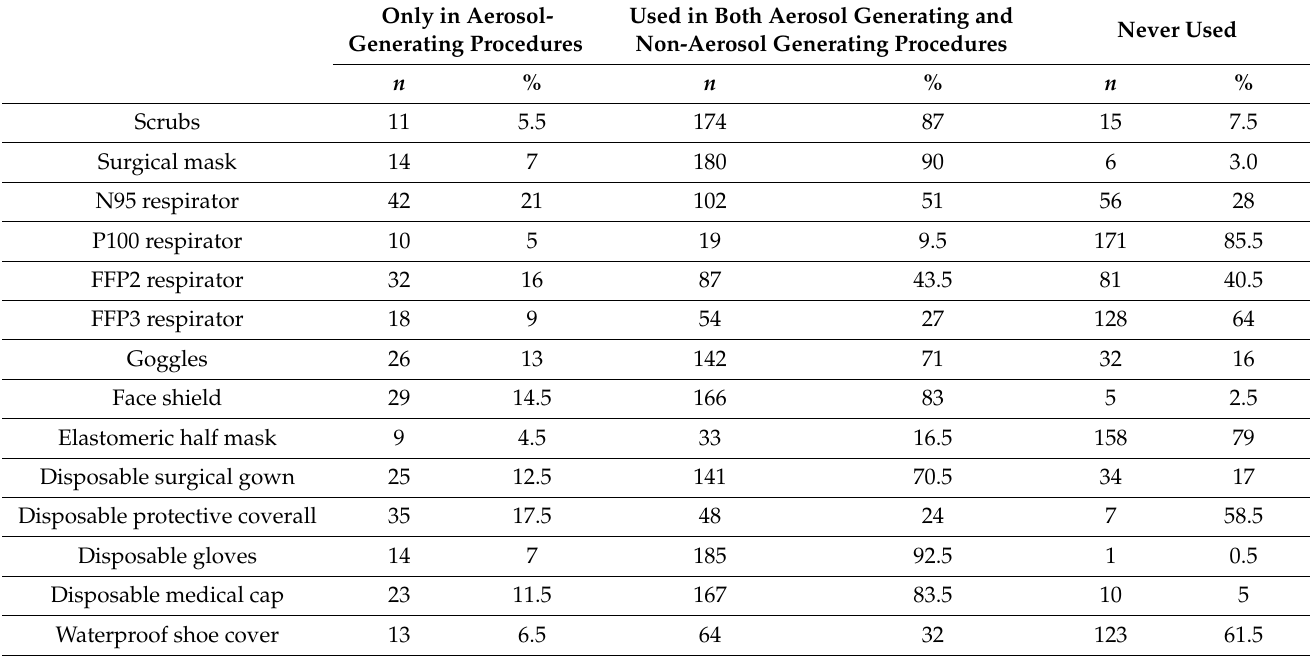
Table 8. Participants’ attitudes towards personal protective equipment (PPE)